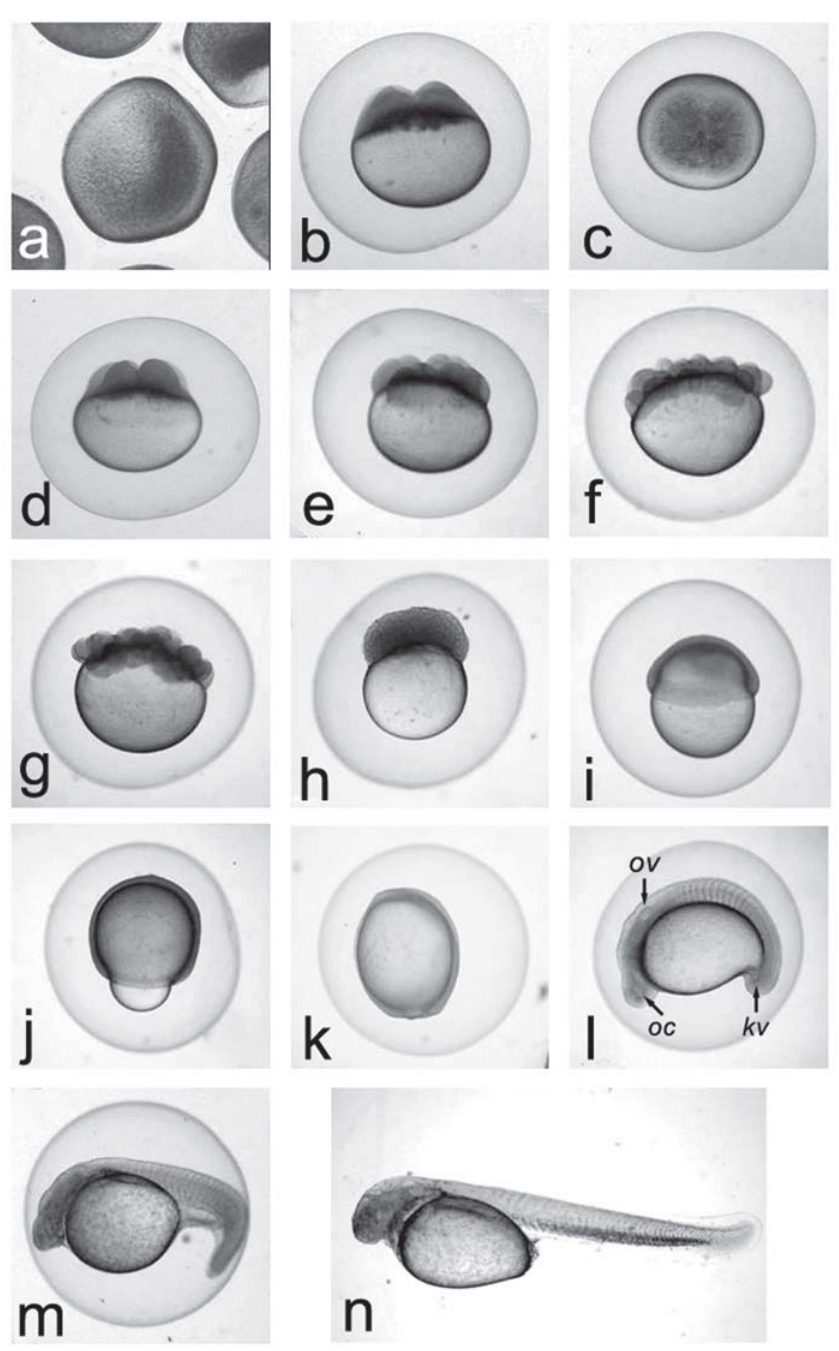
Fig. 1. Steromicroscopic images of fresh oocytes ( a ; 1.6 mm in diameter), eggs ( b - k ; ~2.4 mm in diameter), embryos ( l - m ; ~2.4 mm in diameter), and free embryo ( l - n ; 4.3 mm TL) of jahu in hatchery conditions. a ) recently spawned oocyte covered by the jelly coat (arrow); b ) egg showing a large perivitelline space and two blastomeres of same size (45 min post fertilization, PF); c ) dorsal view of egg seen in b ; d ) egg with four blastomeres of same size (50 min PF); e ) egg with eight blastomeres of same size (50 min PF); f ) egg with sixteen blastomeres of same size (1 h 15 min PF); g ) egg with thirty-two blastomeres of same size (1 h 20 min PF); h ) morula stage (2 h 10 min PF); i ) half of the yolk sphere ( circa 50% epiboly) was covered with the blastoderm (4 h 50 min PF); j ) formation of the yolk plug circa 90% epiboly (6 h 30 min PF); k ) end of epiboly with closure of embryo ring (blastopore) (7 h 30 min PF); l ) embryo exhibiting optic calyx (OC), otic vesicle (OV), Kupffer’s vesicle (KV), and 13 somites (10 h 30 min); m ) embryo within egg envelop exhibiting free, beating tail (13 h 30 min PF); n ) free embryo, the almost transparent body is involved by the primordial fin fold; head and anterior part of body over the yolk sac; non-pigmented retina; mouth is closed; notochord slightly flexed; 39.1 ± 2.0 miotomes ( circa 6 h post